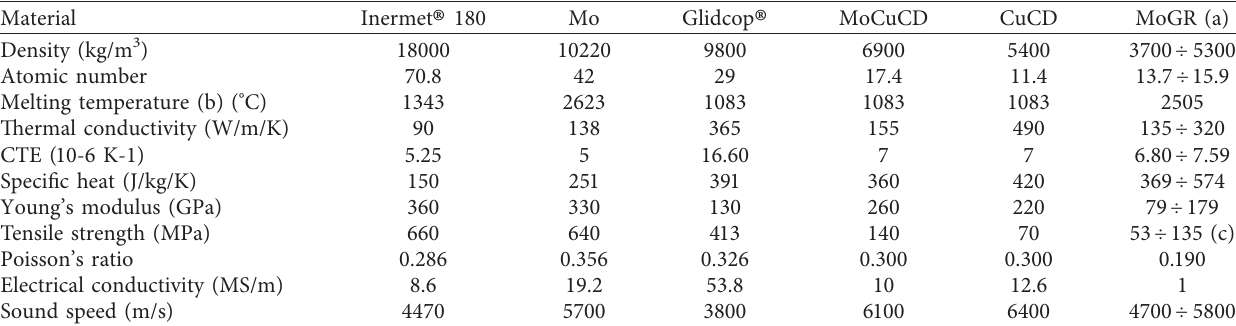
Figure 4: Results of the medium-intensity test on Glidcop ® , hoop strain without smoothing function (blue, green, and red dotted lines), compared with Autodyn simulation (black line). Table 2: Properties of materials tested during the